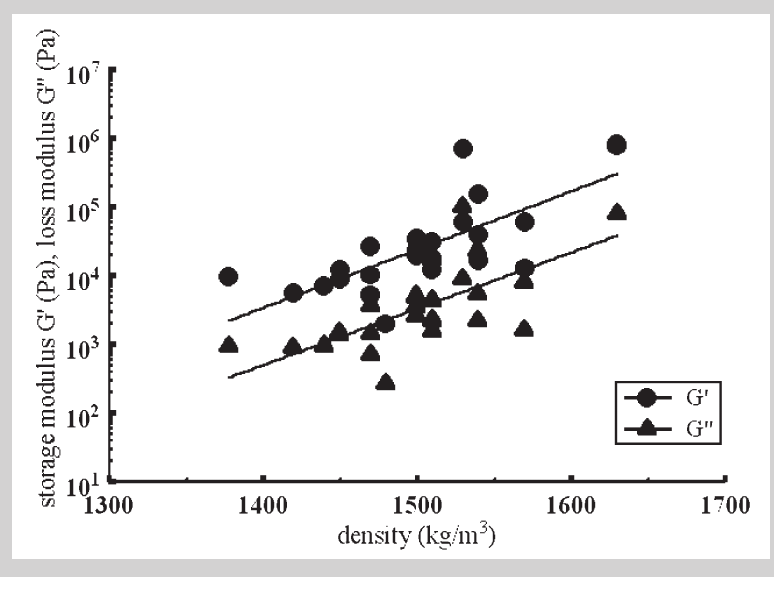
Figure 8: The linear viscoelastic moduli, at a frequency of 1Hz, as a function of the density of the